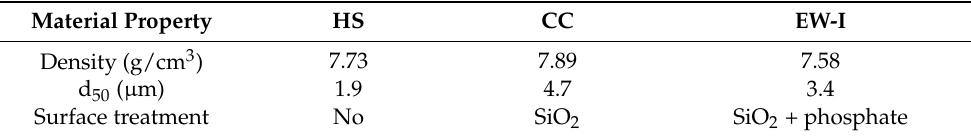
Table 2. CIP materials with and without surface treatment.